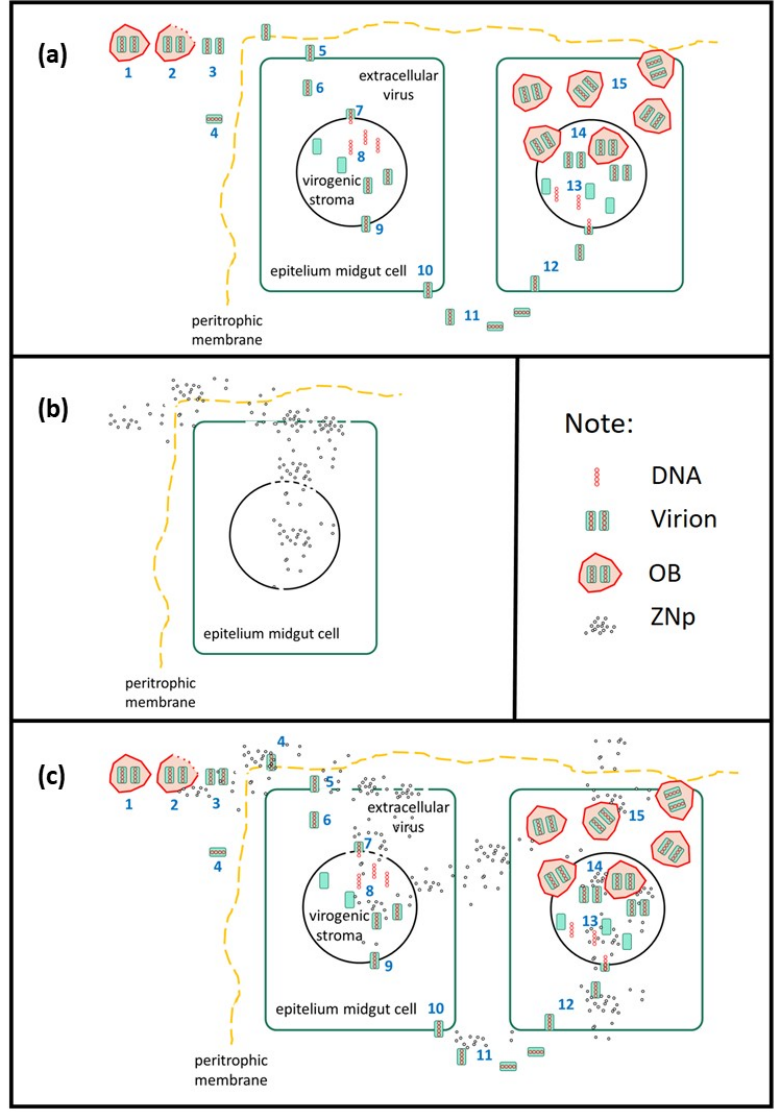
Figure 7. The proposed action mechanism of biocontrol to target on the lethal time: ( a ) Ha NPV 1 , ( b ) ZNPs, ( c ) the synergetic e ff ect of Ha NPV 1 + ZNPs. ( 1. OBs, 2 . Dissolve polyhedrin, 3 . Virions, 4 . Viri- ons penetrate into the peritrophic membrane, 5 . Virions a tt ached the cell membrane, 6 . Virion in the cell cytoplasm, 7 . The viral envelope a tt ached out of the nucleus membrane, 8 . The viral genome inside the nucleus, 9 . Budded virus formation, 10 . Budded virus leaves the cell, 11 . Budded virus out of the cell, 12 . Budded virus infected the other cell, 13 . Virogenic stroma, 14 . OBs in the nucleus, 15 . OBs in the cytoplasm)